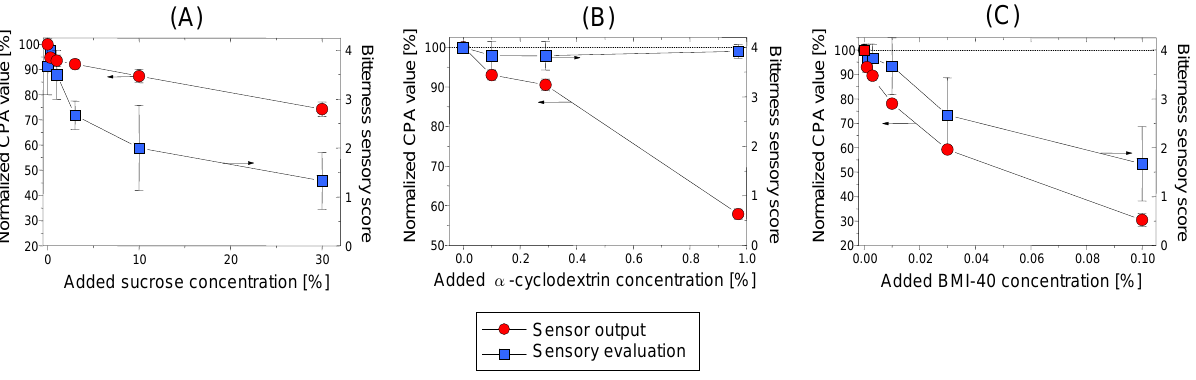
Figure 22. Bitterness suppression effect of bitter-masking materials on quinine hydrochloride using BT0 bitterness sensor. CPA values are normalized to 100, and expressed as mean ±SD (n = 4). The standard deviation for sensory evaluation score is the difference between volunteer taste panels (n = 3). All samples include 10 mM KCl as supporting electrolyte (Reprinted with permission from the Institute of Electrical Engineers of Japan